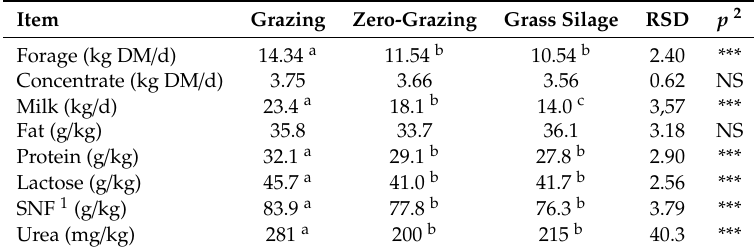
Table 2. Food intake, milk yield and milk composition according to mode of supply of herbage to dairy cows: grazing, zero-grazing or grass